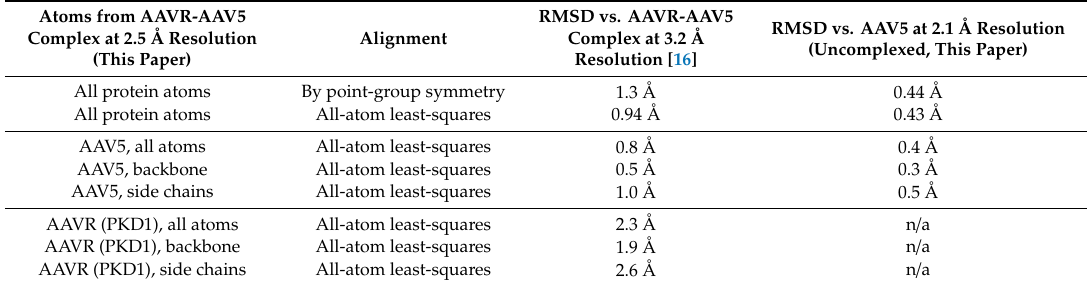
Table 3. Comparison of